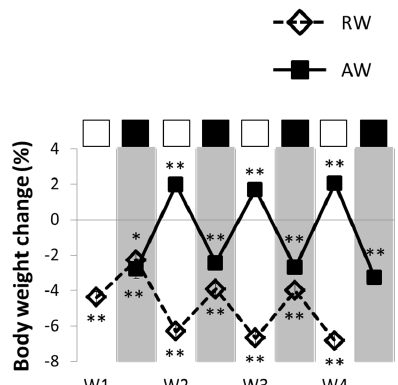
Figure 3. Body weight change during and between work sessions for active workers (AW) and rest-workers (RW). White rectangles indicate work hours for RW. Black rectangles indicate work hours for AW. Data are shown as percentage change relative to baseline. Shaded bars indicate lights off (active phase). Error bars indicate SEM. W1–4 indicates work days 1 to 4. * p < 0.05; *** p < 0.001, compared to baseline.